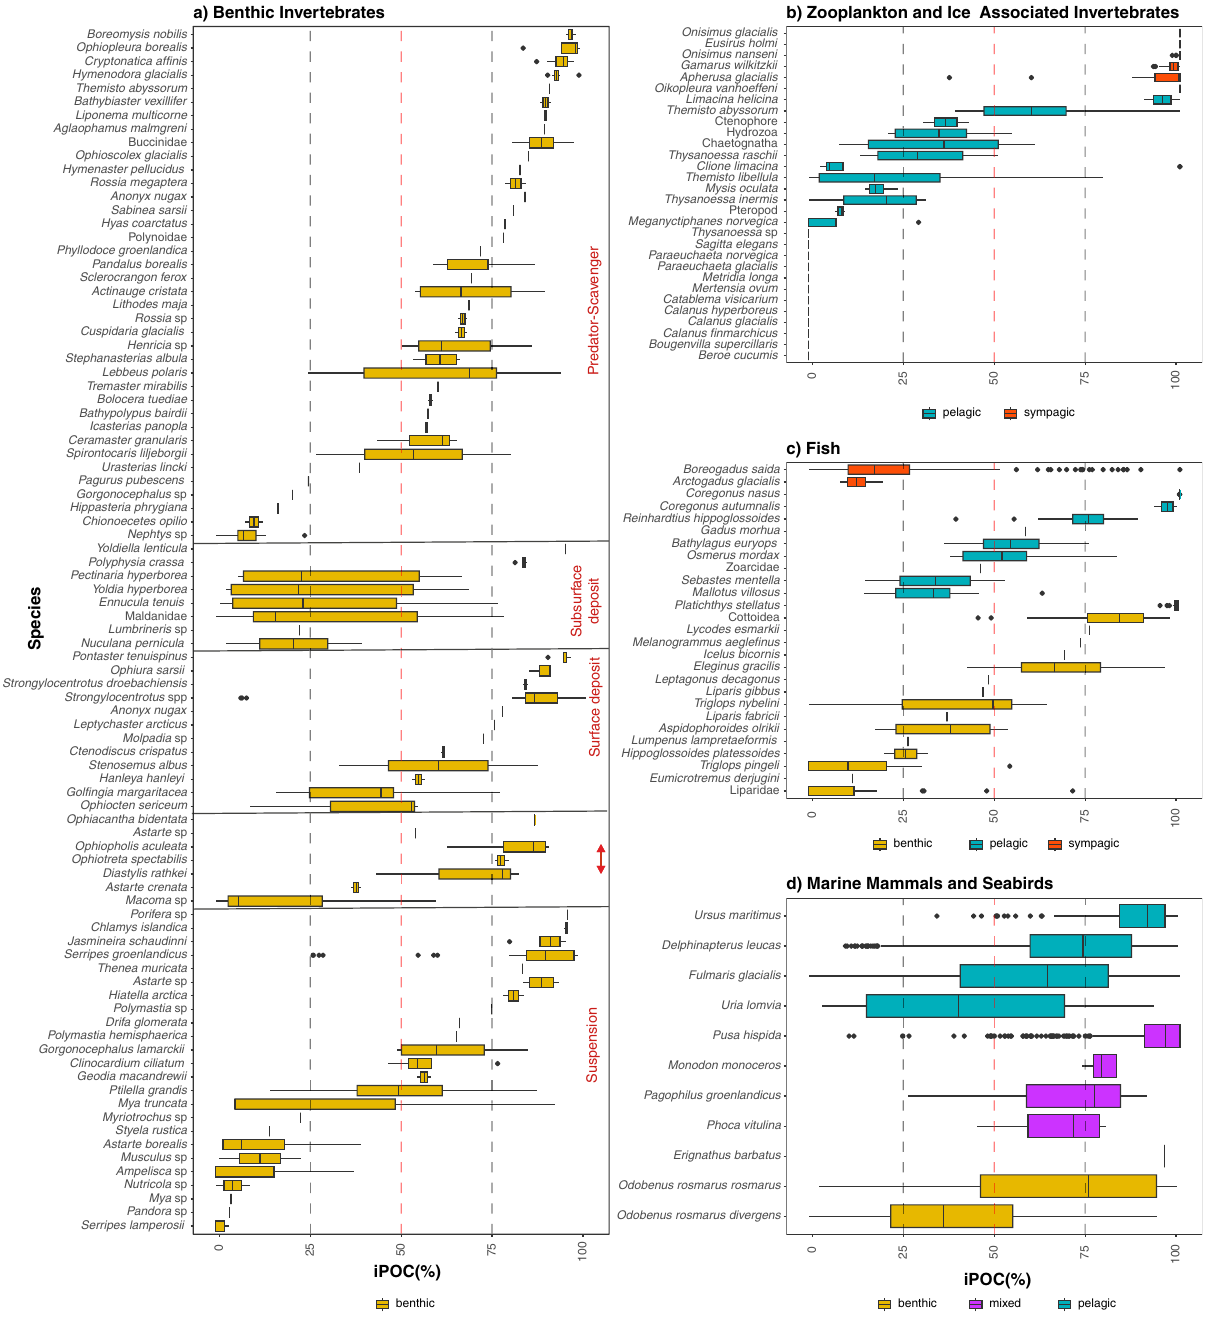
Fig. 2 | Sea ice particulate organic carbon (iPOC) content representing 159 Arctic consumers relative to phytoplankton. Species-binned HBI-based esti- mates of sea-ice carbon content for all individuals ( n =2251) sampled between 1982 – 2019 and grouped by major taxa including a benthic invertebrates sorted by feeding strategy (red text), b zooplankton and ice-associated invertebrates, c fi sh, and d seabirds and marine mammals, color-coded by habitat. 50% iPOC% (red-